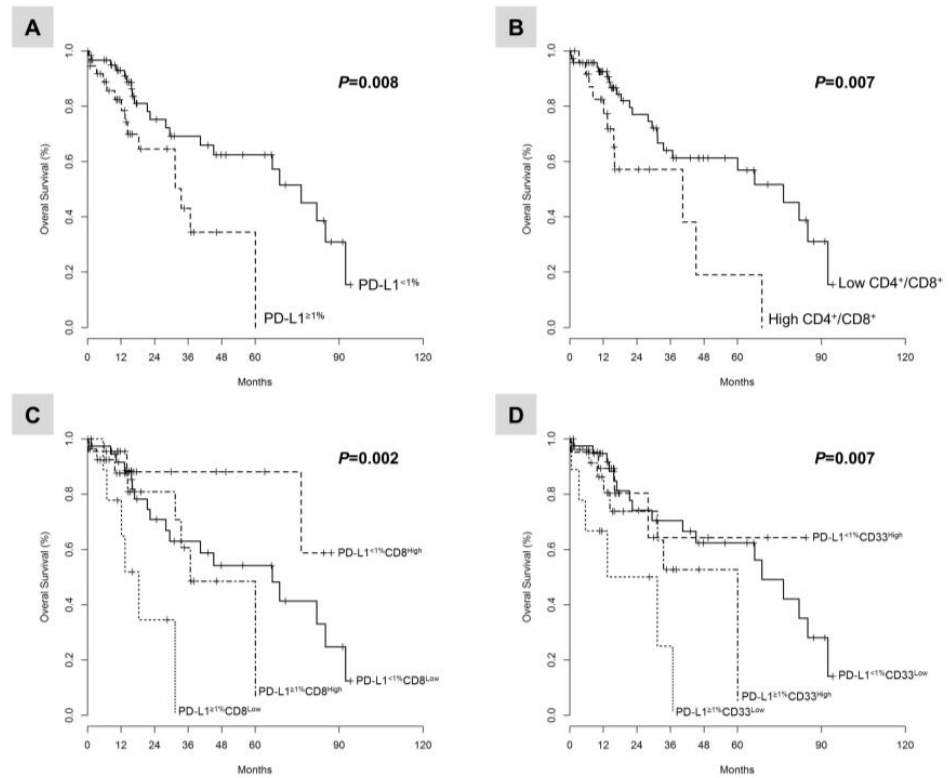
Figure 3. Kaplan-Meier curves illustrate the duration of overall survival according to: ( A ) the PD-L1 expression in TCs; ( B ) the CD4 + /CD8 + ratio; ( C ) the combined analysis of PD-L1 expression in TCs and the CD8 + cell density; and ( D ) the combined analysis of PD-L1 expression in TCs and the CD33 + cell density. Cutoff values were PD-L1 ≥ 1% TCs and median for the CD4 + /CD8 + ratio, the CD8 + and CD33 + cell density, respectively.